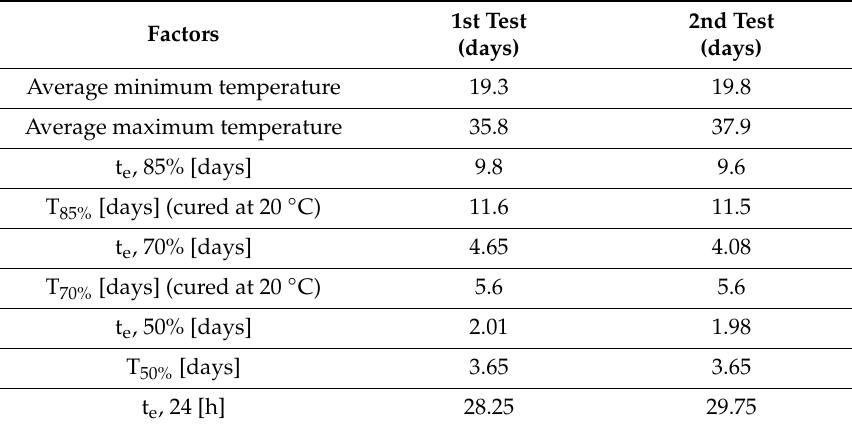
Table 2. Computed concrete formwork removal times and